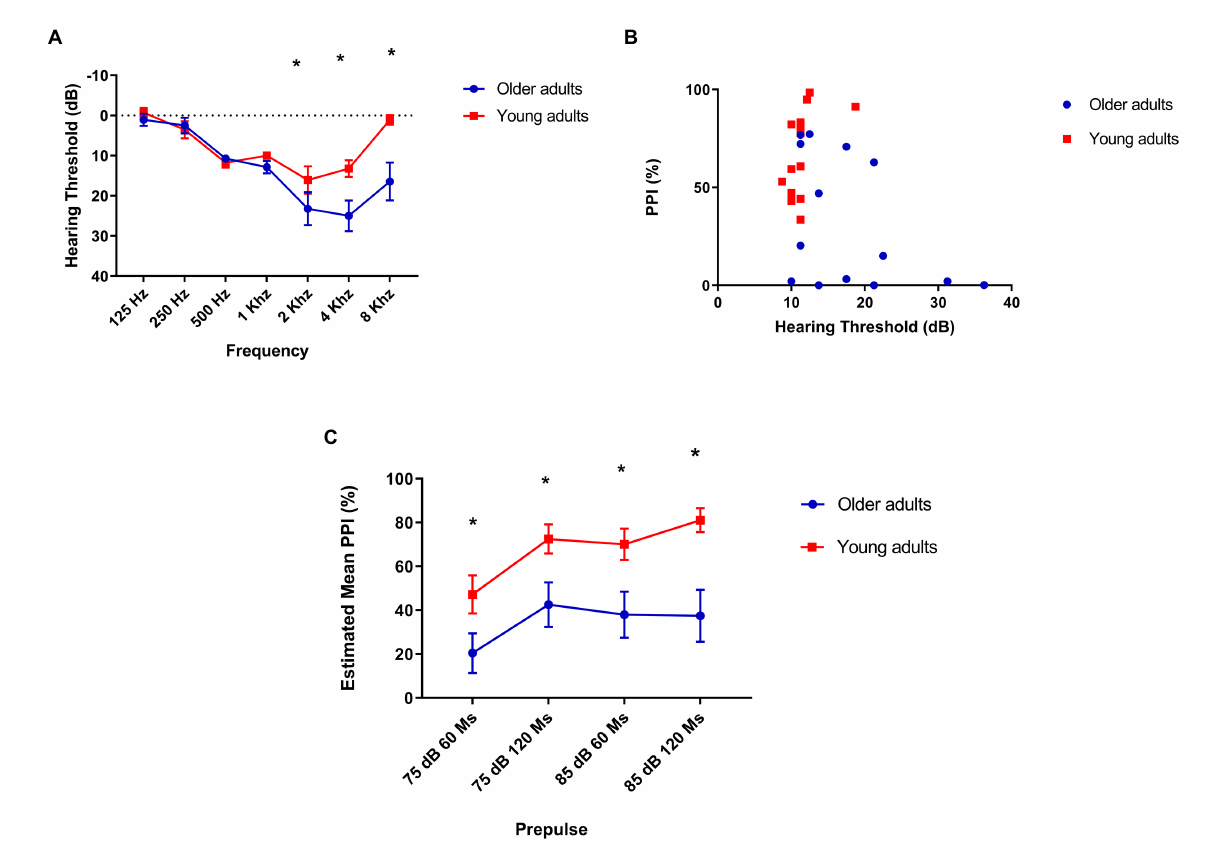
FIGURE 3 (A) Older adults have a higher hearing threshold at 2, 4, and 8 kHz. The lines indicate average loss in decibels at each frequency. 2 kHz: mean 13.21 (young), 23.21 (older) t = − 2.38, p = 0.025. 4 kHz: mean 12.14 (young), hearing threshold of older adults compared to older adults young. Mean = 17.95 (older), 25 (older) t = − 3.1, p = 0.005. 8 kHz: mean 1.07 (young), 16.4 (older) t = − 3.17, p = 0.04; (B) There is a moderate, but not statistically significant correlation between prepulse inhibition and hearing threshold in older adults: Older adults ( N = 14) Spearman’s Rhô ( ρ ) = − 0.45, p = 0.1 and young ( N = 14) Spearman’s Rhô ( ρ ) = − 0.61 p = 0.02. (C) Older adults show less prepulse inhibition than young people at all intervals and intensities tested. Repeated- measures ANOVA found no within-subject interaction (interval/intensity of prepulse + age) effect on PPI: F [2.3, 61.12] = 8.7 p = 0.33, but a simple effect of interval/intensity of prepulse was found: F [2.3, 61.12] = 8.7 p < 0.001. Post hoc analysis showed that young adults group had significantly lower PPI in 75 dB/60 ms than 75 dB/120 ms ( p = 0.017), 85 dB/60 ms ( p = 0.04), and 85 dB/ 120 ms ( p = 0.005) as older adults had significantly lower PPI in 75 dB/60 ms than in 75 dB/120 ms. Older ( N = 14) and younger ( N = 14). Repeated-measures ANOVA revealed a significant effect of age between groups on PPI in every interval/intensity of prepulse tested: F [1,26] = 11.3 p = 0.002. 75 dB/60 ms: Mean = 21.36 (older), 47.23 (young N = 14)— F [1,26] = 4.56, p = 0.042;